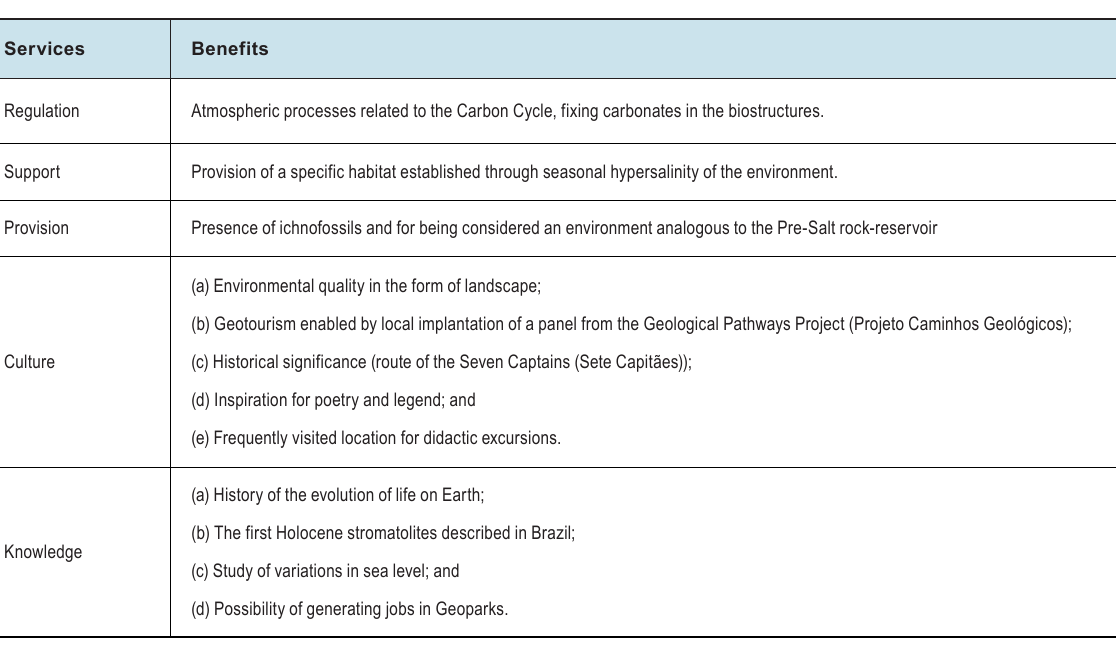
Table 1 - Ecosystem services and respective benefits attributed to Geodiversity identified at Lagoa